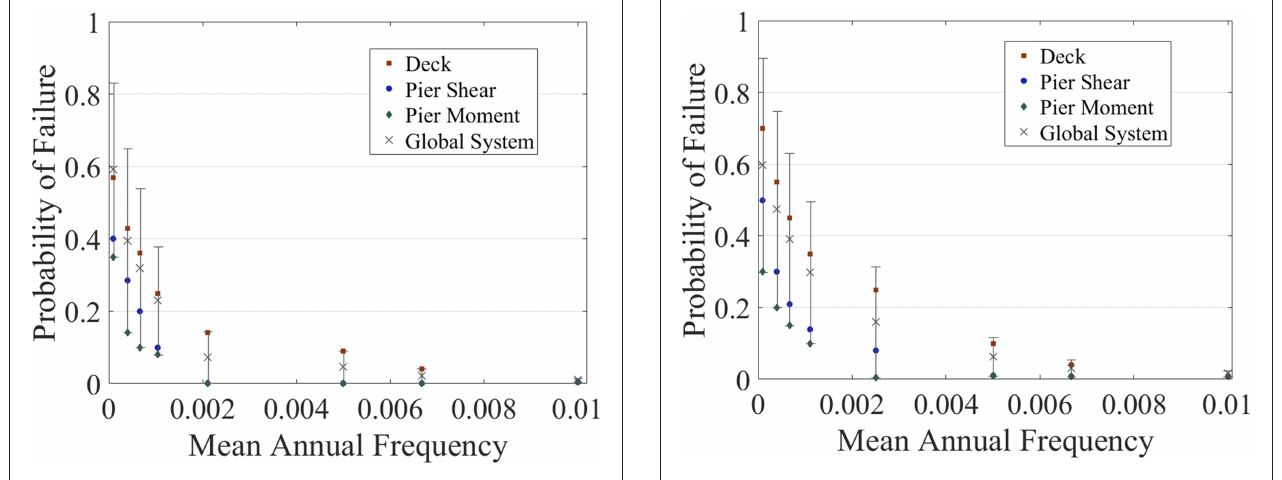
FIGURE 7 | Component and systemic probability of failure to earthquake hazard.